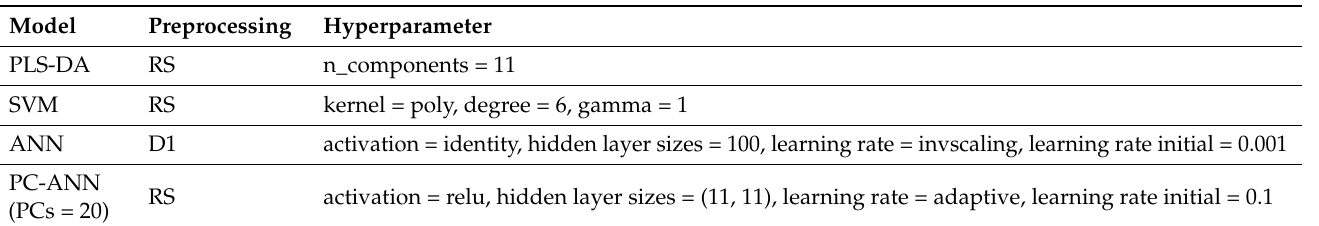
Table 5. Optimal hyperparameters used for machine learning.